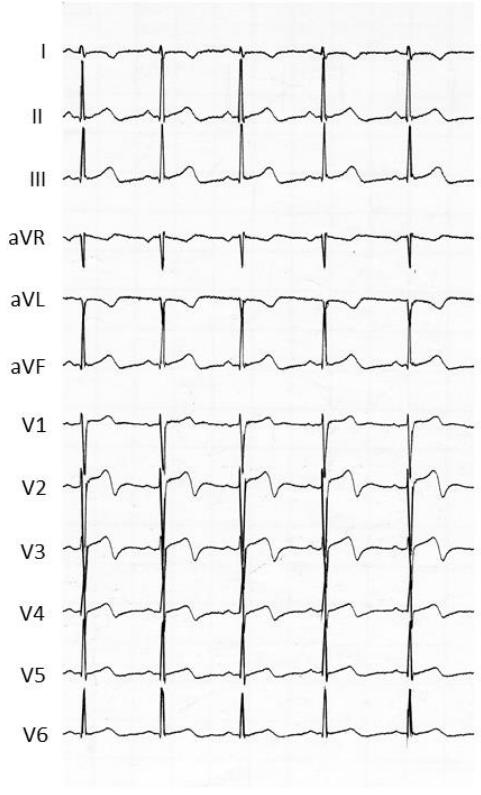
Figure 2. Acute electrocardiographic changes associated with typical chest pain observed in a cancer patient treated with 5-fluorouracil. In this patient, the coronary angiography was